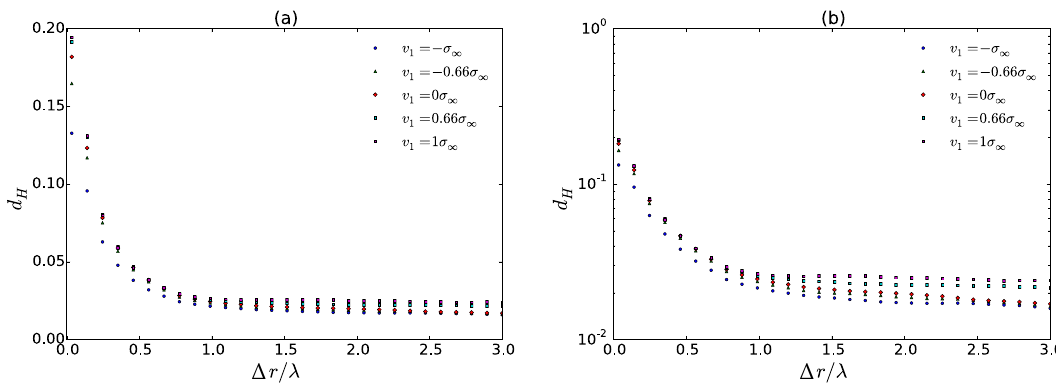
Figure 17. ( a ) Hellinger distance d H ( ∆ r ) for different v 1 and variable step width ∆ r for the purely nonlocal case. The Hellinger is close to zero and only increases at around ∆ r ≈ λ ; ( b ) semi-logarithmic plot of the Hellinger distance d H ( ∆ r )